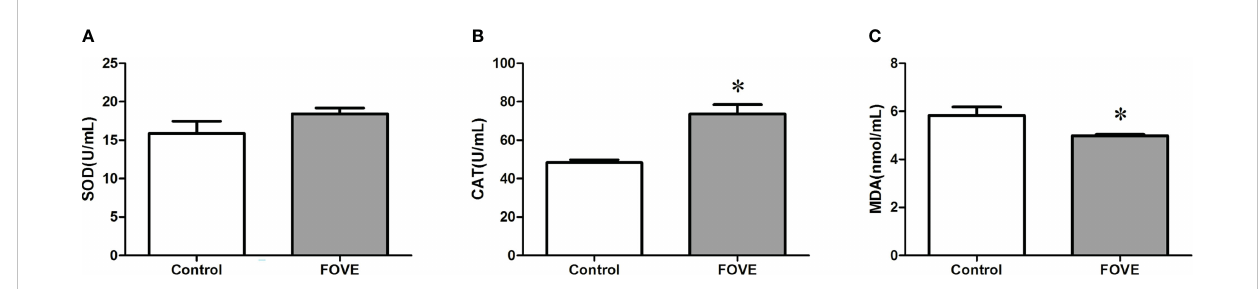
FIGURE 3 Antioxidant status of embryo culture medium. Values are shown as mean ± SD. *Signi fi cant difference compared with the control group ( P < 0.05). (A – C) shows the effect of dietary FO and VE on the antioxidant status of embryo culture medium. The activity of CAT was increased when the diet was supplemented with FO and VE (P < 0.05). In contrast, FO and VE supplementation resulted in decreased MDA levels in embryo culture medium, but the activity of SOD did not differ among the groups (P >